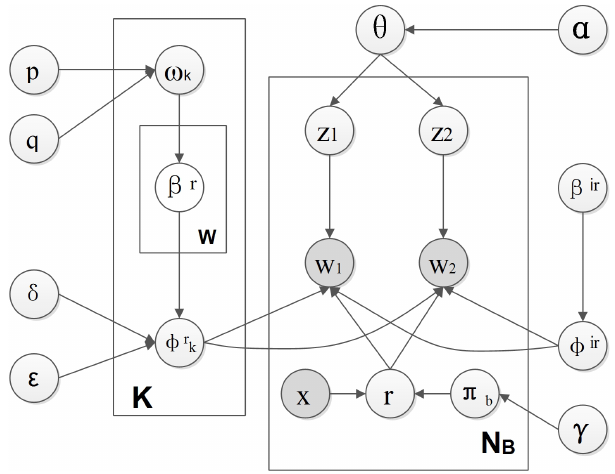
Figure 3. The graphical model of BiTTM. Table 2. Symbol